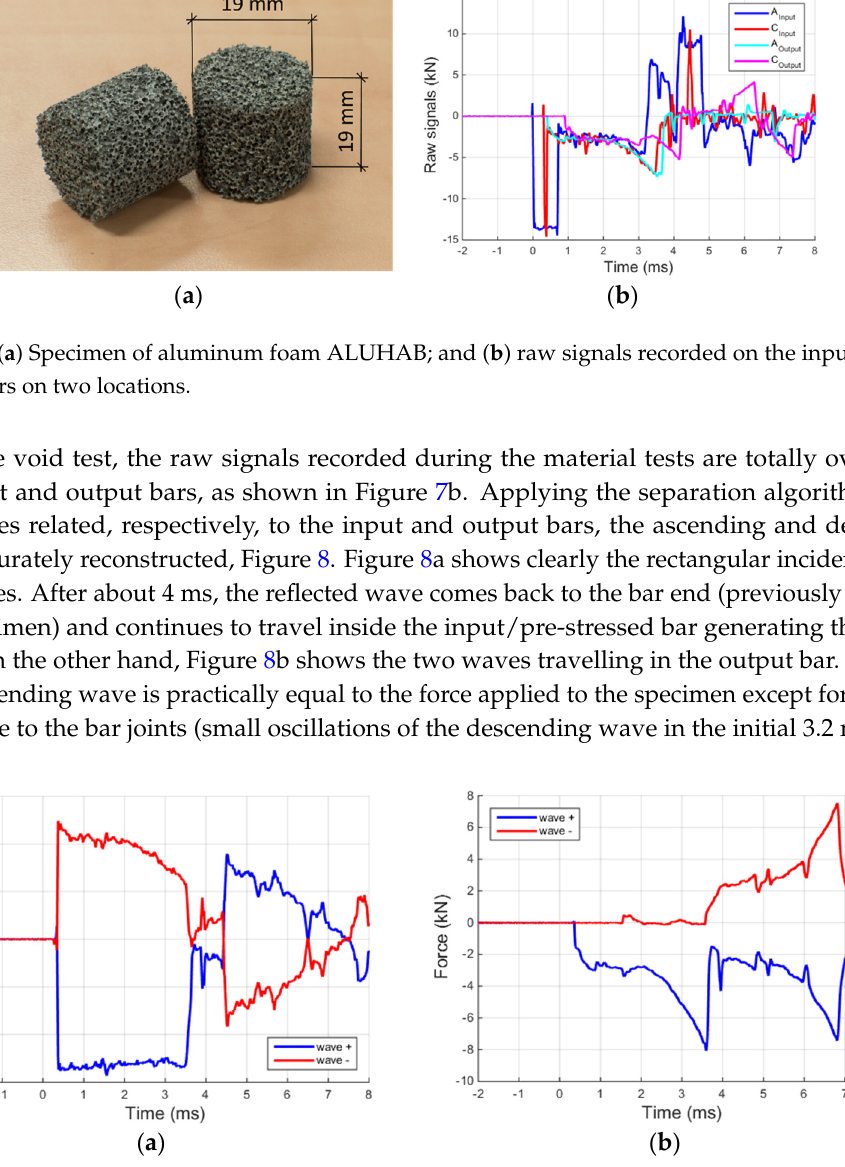
( b ) Figure 6. ( a ) Equilibrium check at input ‐ output bar interface; and ( b ) comparison between displacements obtained with Hopkinson bar theory and with the fast tracking optical algorithm . The optical displacement reported in the graph is the average displacement of the targets adjacent to bar interface (targets 5,6 for the input bar and 7,8 for the output bar). The three curves of Figure 6b, based on two independent measurement data sets, are practically coinciding up to about 4 ms, thus demonstrating once again the accuracy of the data processing implemented. After the detachment of the two bars, some oscillations reduce the accuracy of the Hopkinson bar elaboration (especially for the input bar). However, this can be readily identified and controlled thanks to the high ‐ speed camera measurements, and in no way would it influence the outcome of compression tests (already completed by that time). 3.2. Foam Tests Following the static calibration of the strain transducers and the dynamic tuning of separation algorithm achieved with the void test, it is straightforward to apply the MHPB ‐ SM technique to an actual compression test on foamed material. A series of such compression tests have been performed on cylindrical specimens with a diameter of 19 mm and a length of 19 mm (Figure 7a). The specimens have been cut using electrical discharge machining from a block of ALUHAB